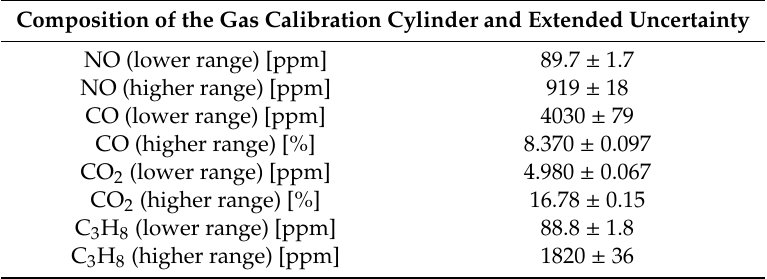
Table 2. Composition of the gas calibration cylinder and extended uncertainty (95% confidence interval).